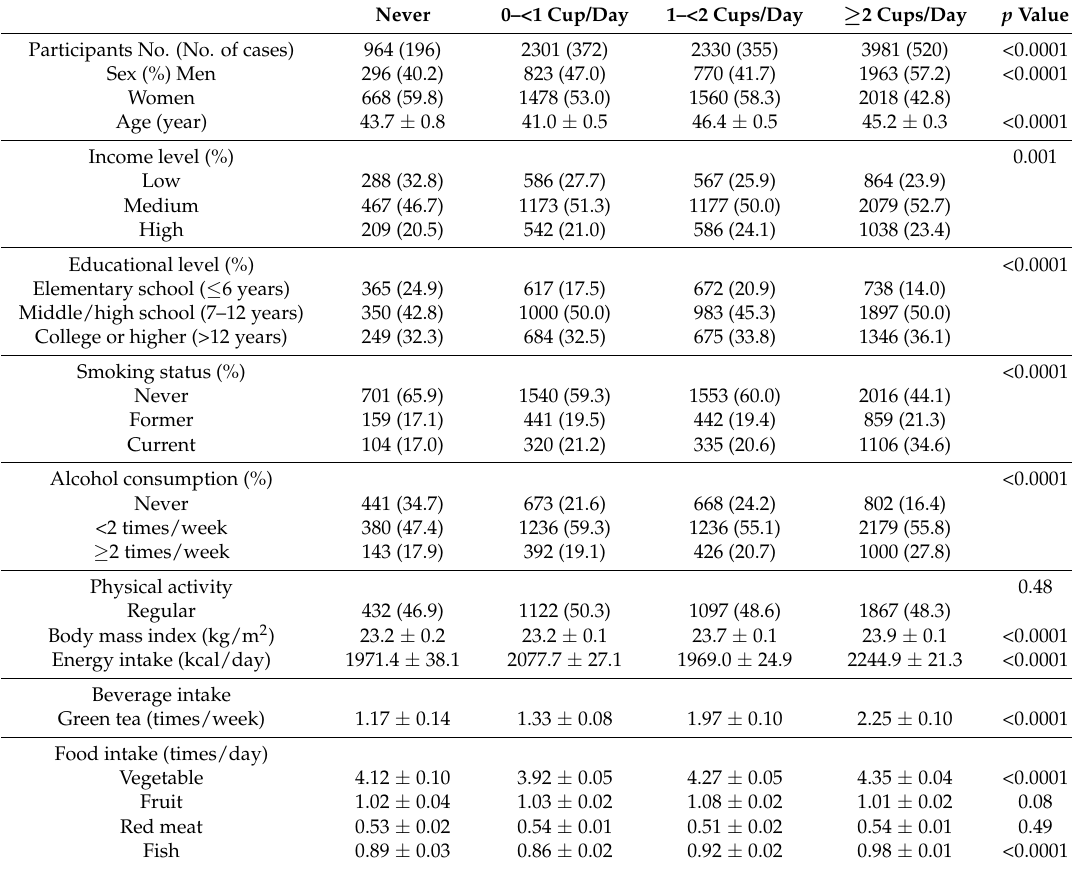
Table 3. Demographic characteristics of subjects according to coffee consumption ( n = 9576) a